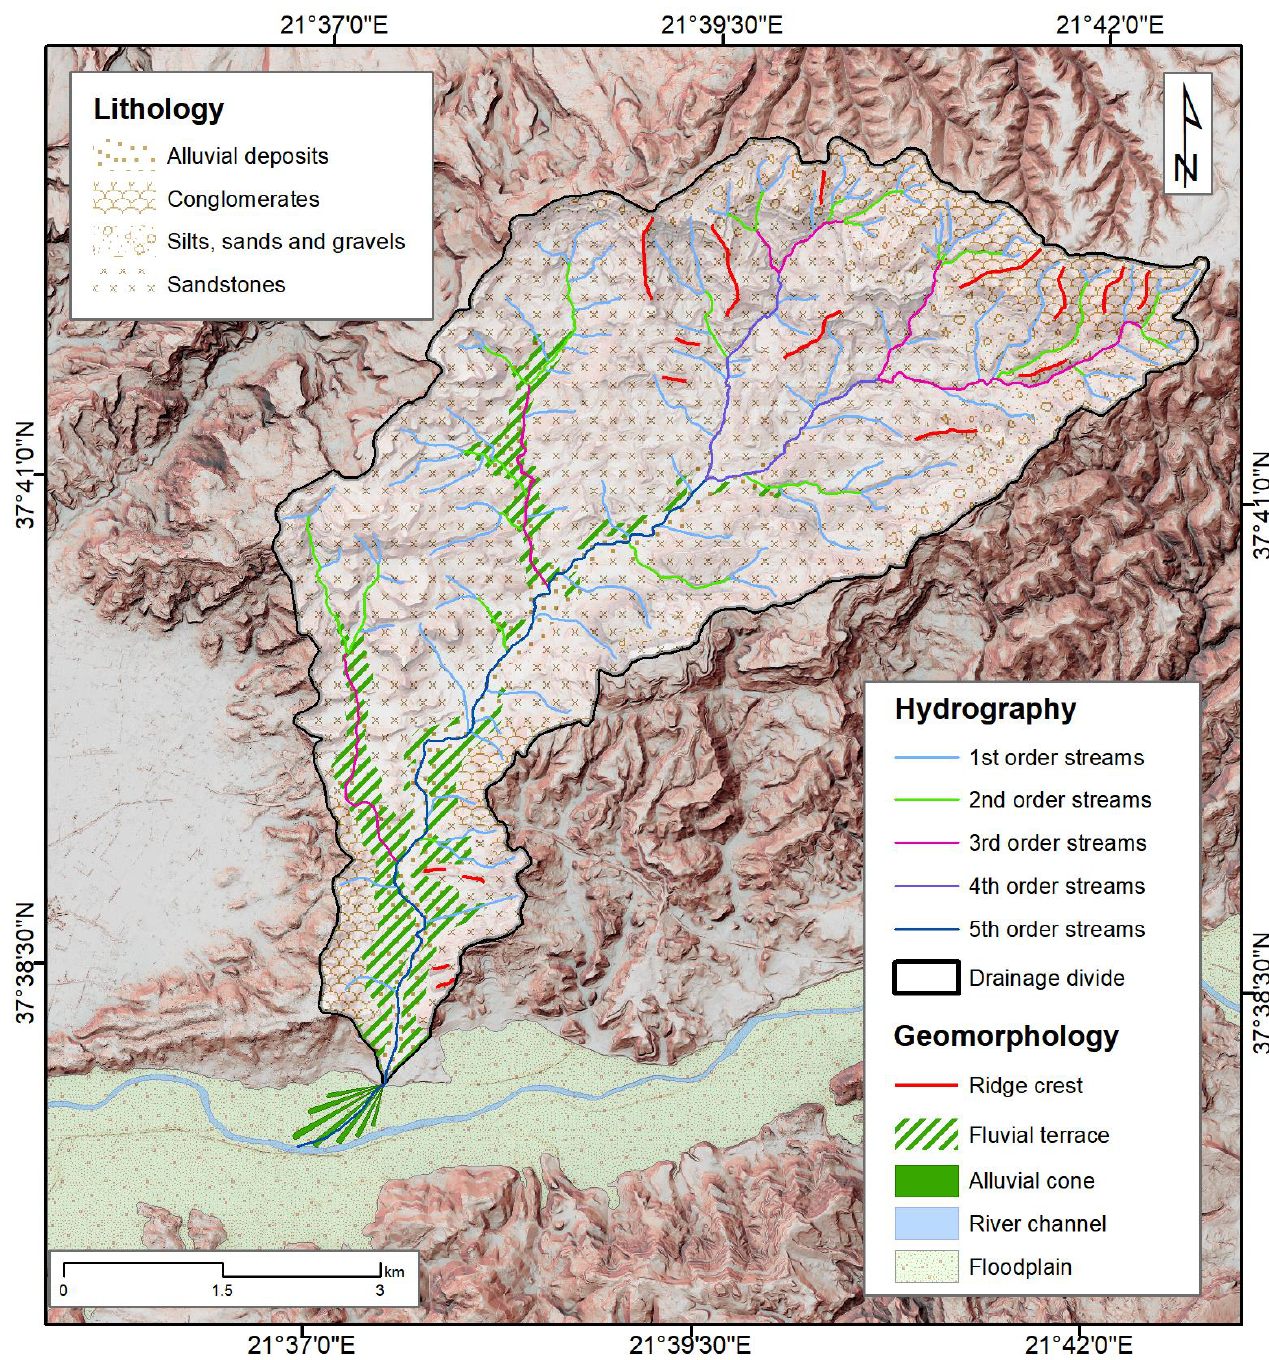
Figure 5. Simplified geomorphological map of the Kladeos River drainage basin. The longitudinal profile of the Kladeos River’s main channel, as displayed in Figure 6a, reveals a topographic landscape that transitions from a mountainous terrain in the northeast part of the basin to relatively flat lowlands near the lower reaches of the river. In the mountainous region, the slopes are quite steep, reaching a gradient of 16.5%, while in the low-lying areas, the gradient is much gentler at 1.36%. It is noteworthy that the steep portions of the drainage network, correspond to the 3rd order streams that anomalously drain directly into the main channel. The combination of these two factors leads to a substantial increase in water volume and velocity that flows into low gradient areas, thereby enhancing the likelihood of a flood